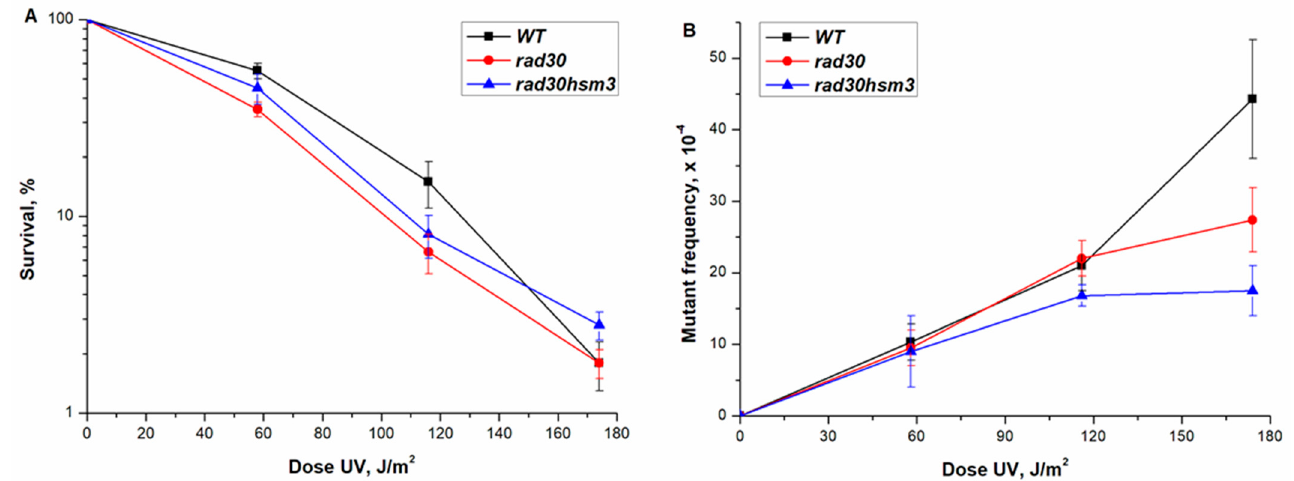
Figure 5. Sensitivity and mutagenesis in different strains after UV irradiation at different doses. The viable titer was determined, and the percentage of survivals was calculated. The mean ± SEM values obtained from four independent experiments are plotted. ( A ) UV-induced sensitivity in strain wild-type (LMG-3031) and mutant strains rad30 ∆ (TAE-153), rad30 ∆ hsm3 ∆ (TAE-152); ( B ) Frequencies of UV-induced mutations in wild-type (LMG-3031) and mutant strains r ad30 ∆ (TAE-153), rad30 ∆ hsm3 ∆ (TAE-152).